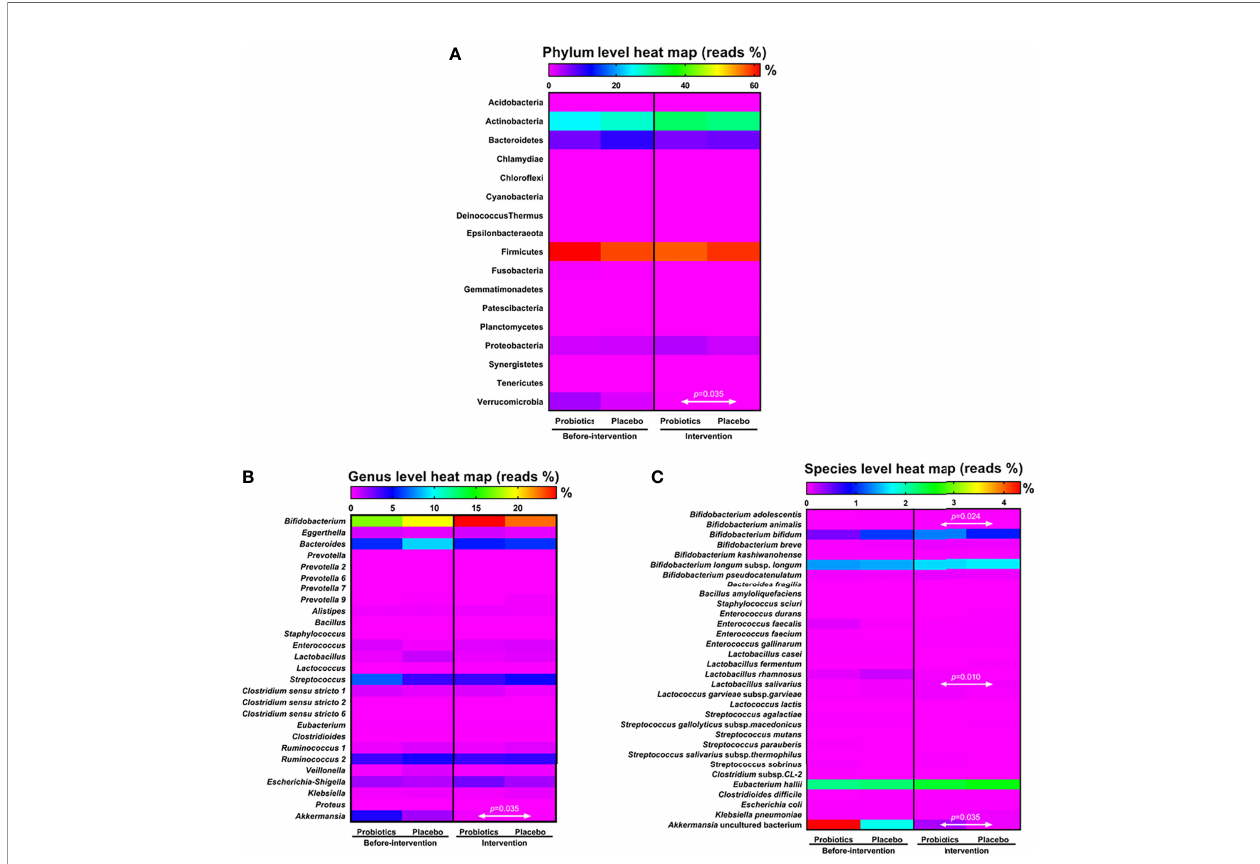
FIGURE 1 | Analysis of microbiota dispersion (%) among patients with T1DM. The data present microbiota changes at the phylum (A) , genus (B) , and species levels (C) . The amount of microbiota was normalized with that observed before intervention. Statistical difference between the probiotic group and placebo is indicated by a white two-way arrow. Placebo group: T1DM patients receive regular insulin treatment but no additional probiotic supplementation. Probiotic group: T1DM patients receive regular insulin treatment with additional probiotic